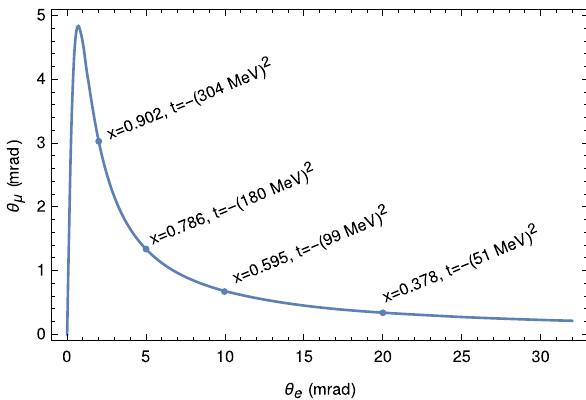
Fig. 1 The elasticity curve, i.e. the relation between the muon and electron scattering angles for 150 GeV incident muon beam momentum